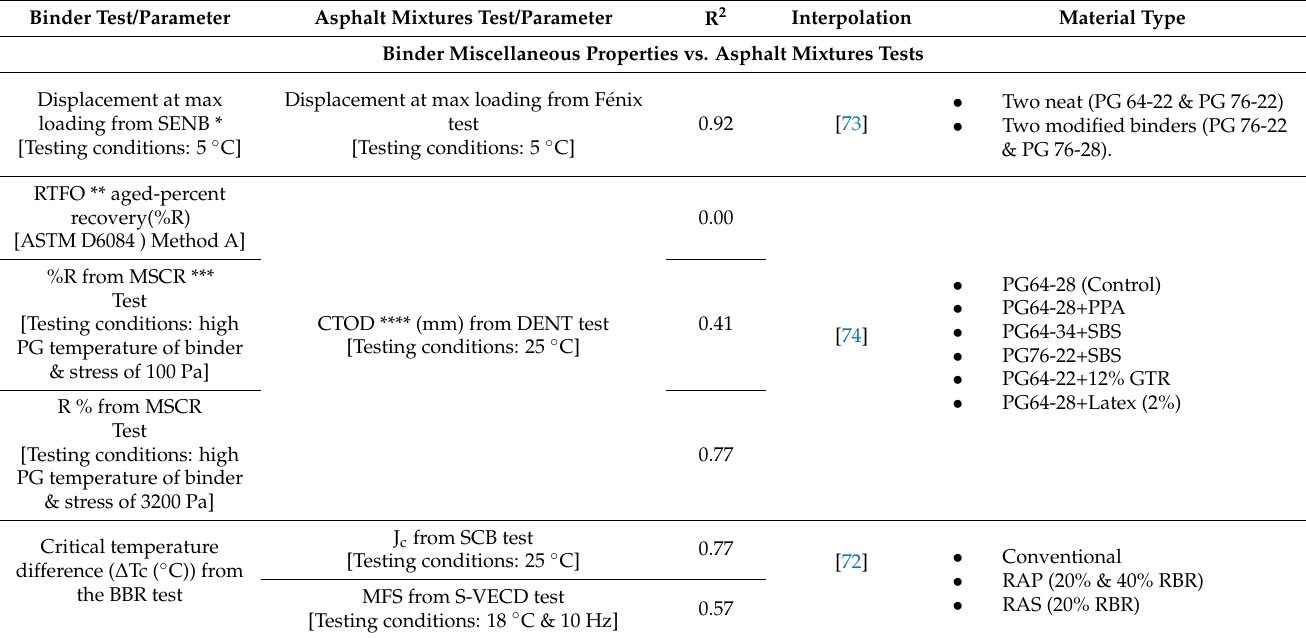
Table 2. Correlations between the properties of the bitumen from various miscellaneous tests and cracking properties of asphalt mixtures from various